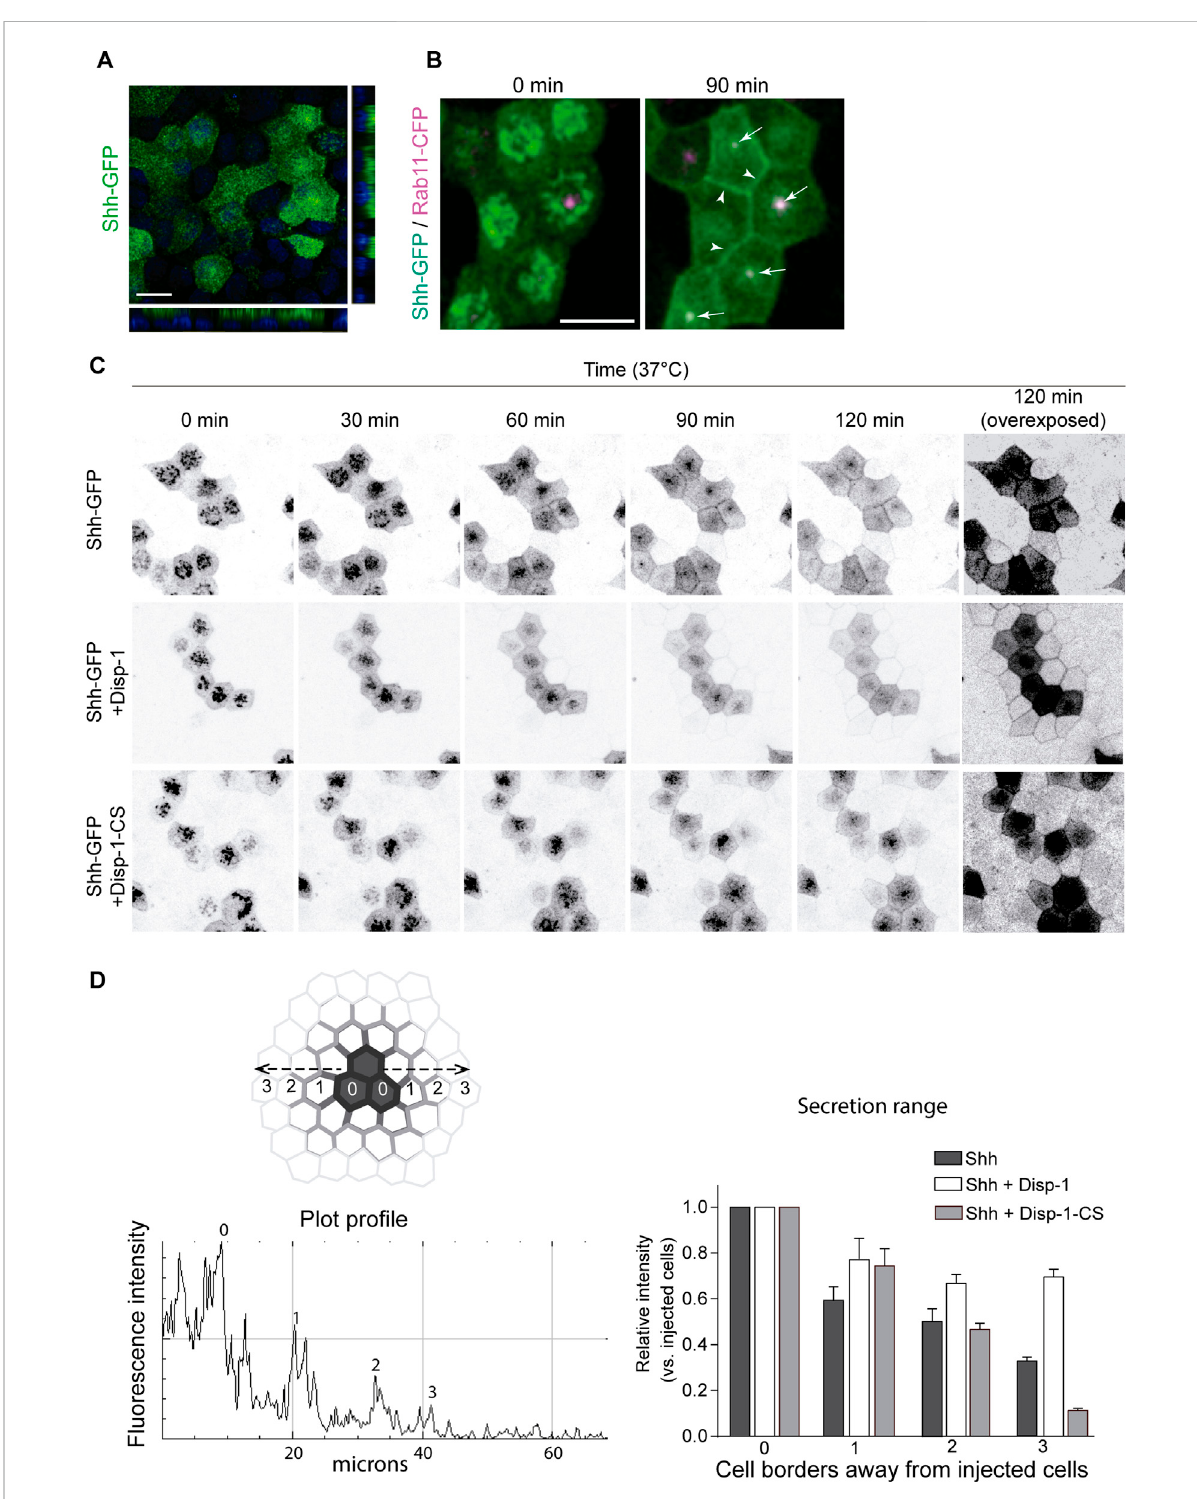
FIGURE 8 Live-cellimagingofShh-GFPincellscoexpressingDisp-1orDisp-1-CS.PolarizedMDCKcellsinglasscoverslipsweremicroinjectedtoexpressShh-GFP aloneortogetherwithDisp-1orDisp-1-CS. (A) Shh-GFPshowsapicaldistributionafter4 hofexpression. (B) PolarizedMDCKcellsstablyexpressingRab11-CFP weremicroinjectedwithShh-GFPplasmidandafter45 minofexpressionat37 ° C,thecellswereincubatedfor2 hat20 ° Ctoarresttraf fi ckingofproteinatthe TGN(time=0)andthenshiftedto37 ° CtoreestablishexitfromtheTGNfor90 min.ArrowheadsshowbasolaterallyarrivedShh-GFP,whilearrowspoint